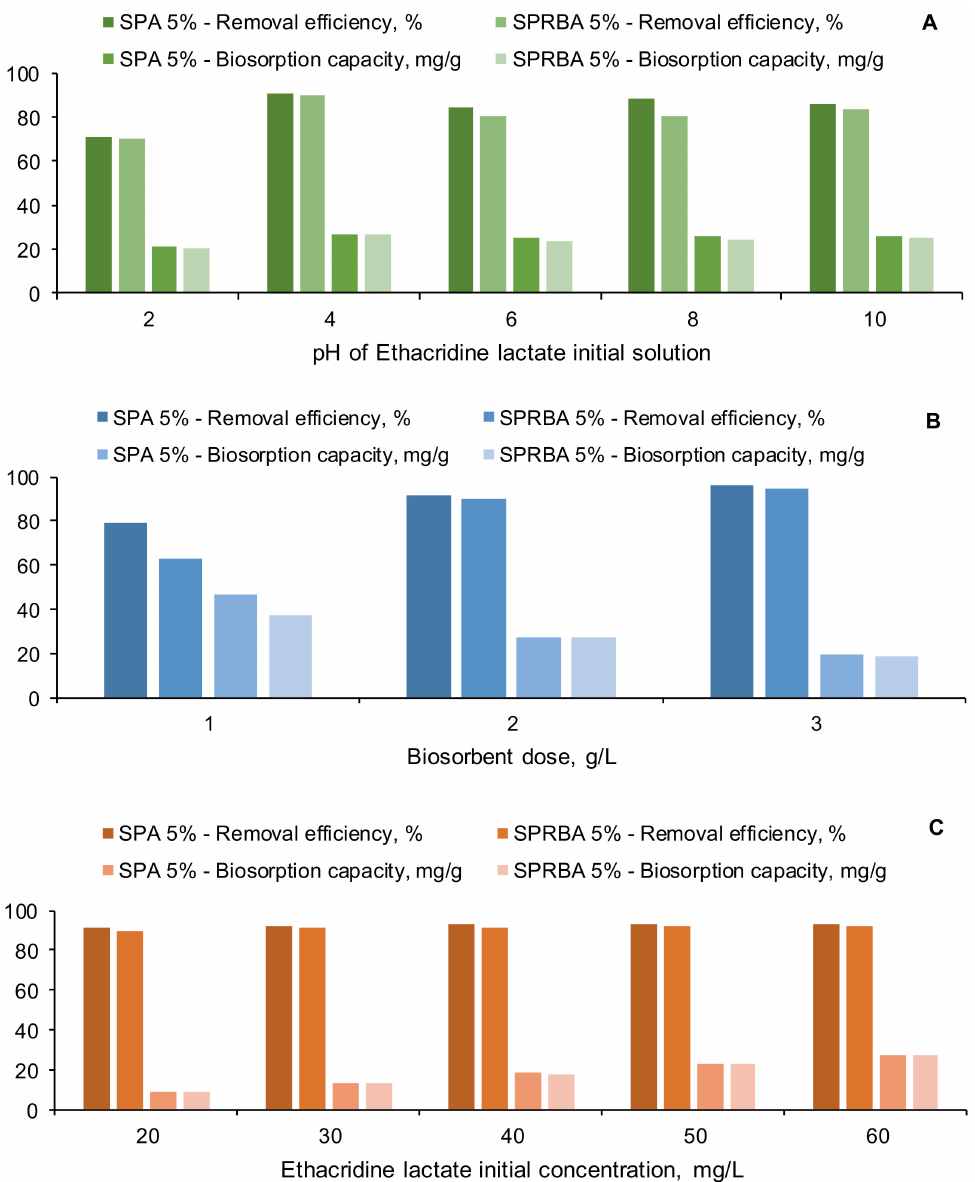
Figure 6. Influence of parameters on the biosorption process ( A ): effect of EL solution initial pH (volume of EL solution: 30 mL; concentration of EL solution: 60 mg/L; biosorbent dose: 1 g/L); ( B ): effect of biosorbent dose (volume of EL solution: 30 mL; concentration of EL solution: 60 mg/L; pH of EL solution: 4); ( C ): effect of EL solution initial concentration (volume of EL solution: 30 mL; pH of